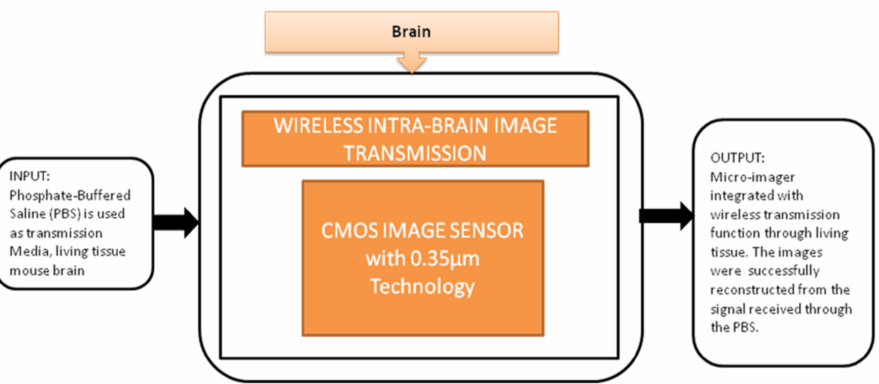
Figure 19. Wireless intrabrain image transmission using CMOS image sensor implanted in rat